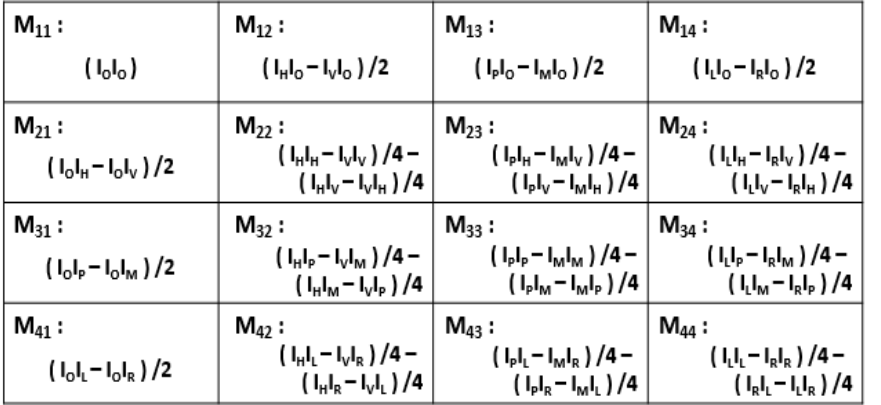
Figure 3. A matrix array showing the polarization measurements necessary to obtain each Mueller matrix element. A two-letter combination corresponds to one measurement. For example, the combination (I V I P ) means that the PSG is adjusted to obtain linear polarization along the vertical axis ( y axis) for incoming light and PSA is adjusted to recover linear polarization with a +45° offset for reflected light. I 0 corresponds to unpolarized light.